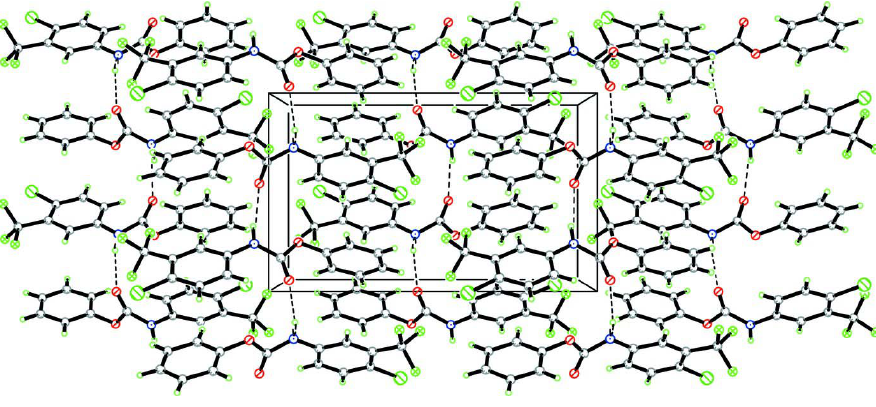
Figure 1 The molecular structure of the title molecule, with the atom-numbering scheme. Displacement ellipsoids are drawn at the 30% probability level.